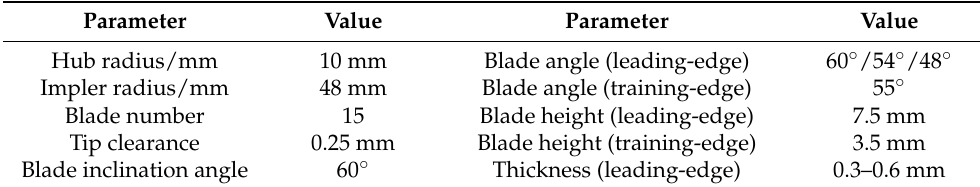
Table 3. Main structural parameters of the semi-open